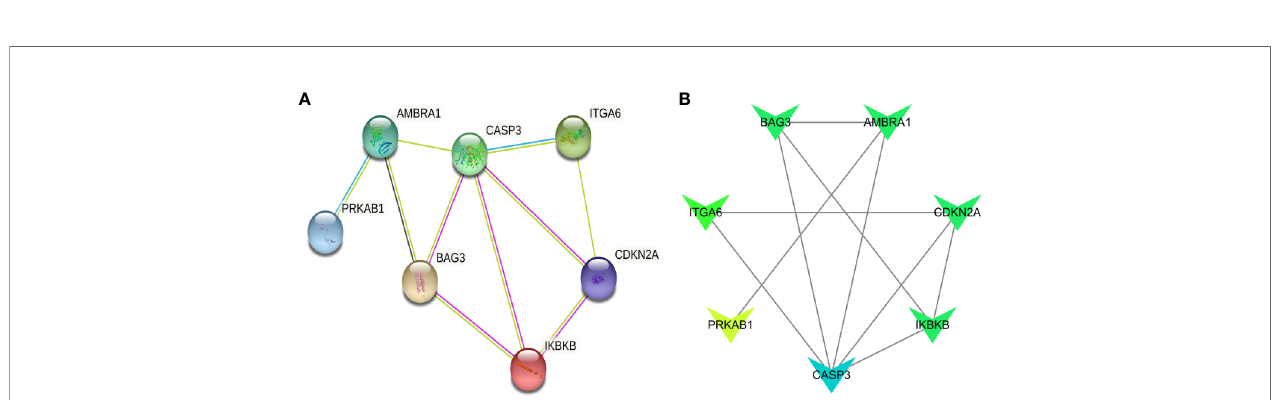
FIGURE 4 | Co-expression analysis of seven ARGs. (A) The co-expression network of seven ARGs. (B) The degree of association between the seven genes, the darker the color, the more connections.